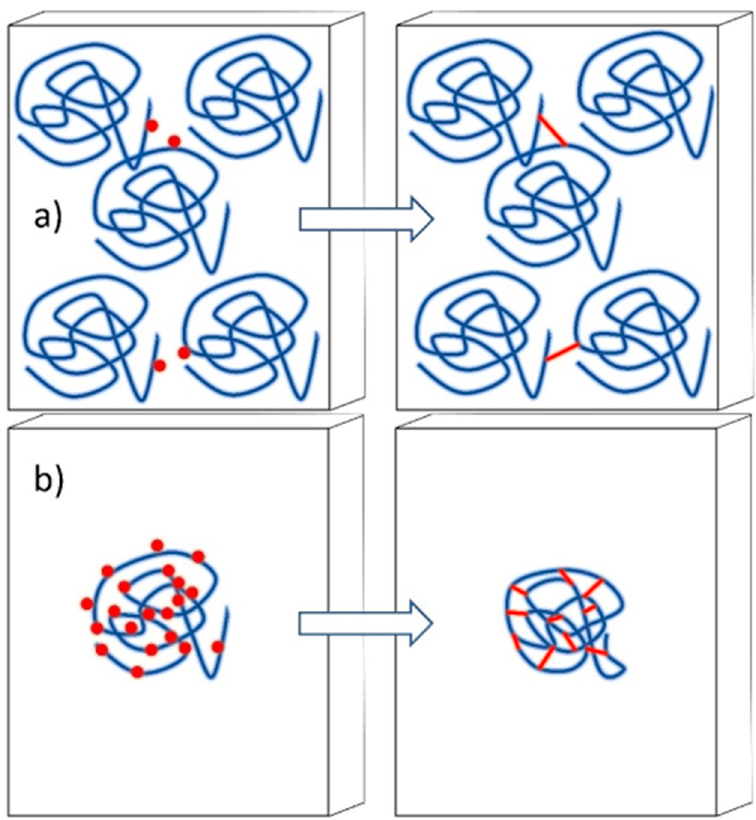
Figure 22. Controlling the dominating crosslinking process: ( a ) high polymer concentration and low dose rate—n average less than one radical present simultaneously on each chain—domination of intermolecular crosslinking, ( b ) low polymer concentration and high-dose pulse irradiation—many radicals present simultaneously on each chain—domination of intramolecular crosslinking.